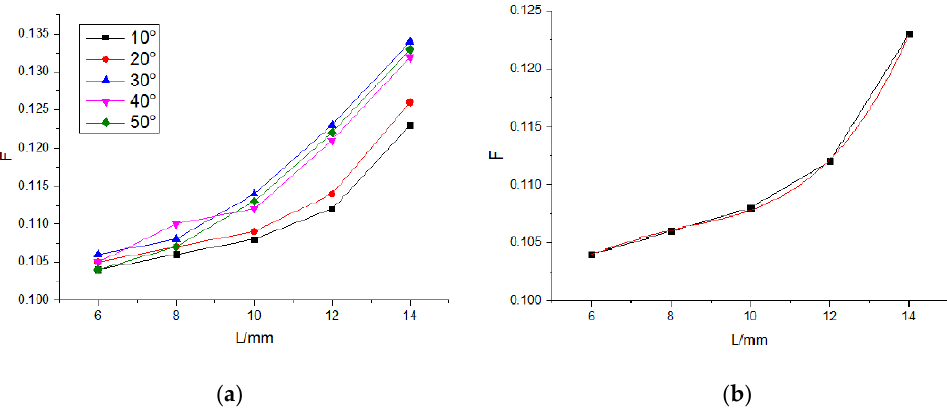
Figure 6. The relationship curve between F and L : ( a ) the law of change of F with L under different initiation angles, and the ( b ) fitting curve of F and L when R, h, and α are fixed values. It can be observed from Figure 6a,b that the stress intensity factor correction factor F increases as the crack length L increases.